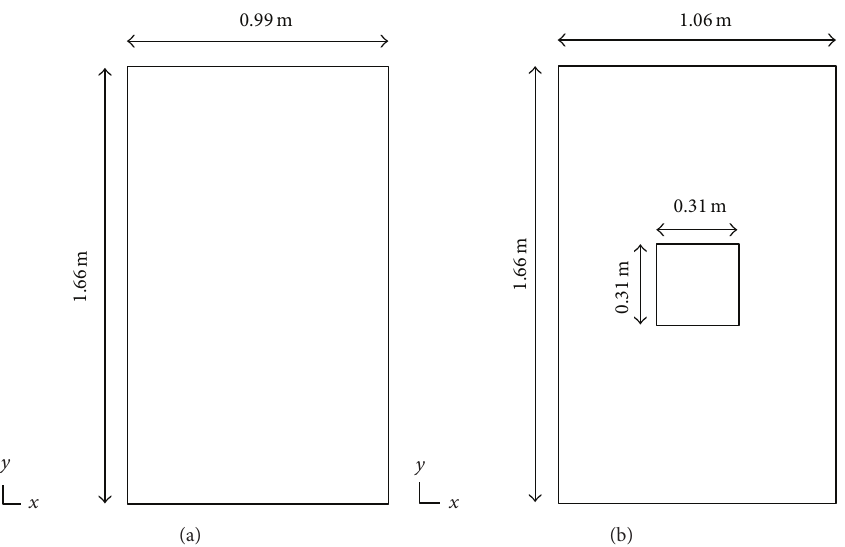
Figure 1: (a) Typical solar panel 0.99 × 1.66m × m and (b) a 0.31 × 0.31 m × m rectangular shape hole cut at the panel gravity center. The solar panel with hole measures 1.06 × 1.66m × m. Each panel type exposes to wind the same surface area.